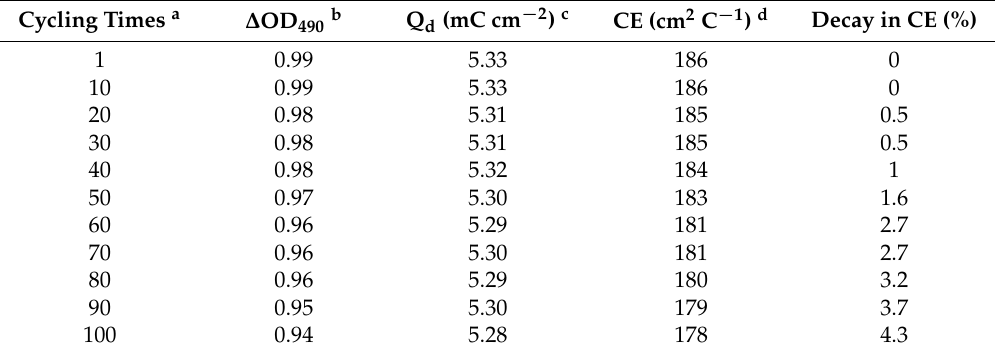
Table 4. Coloration efficiency of polyamide 5b